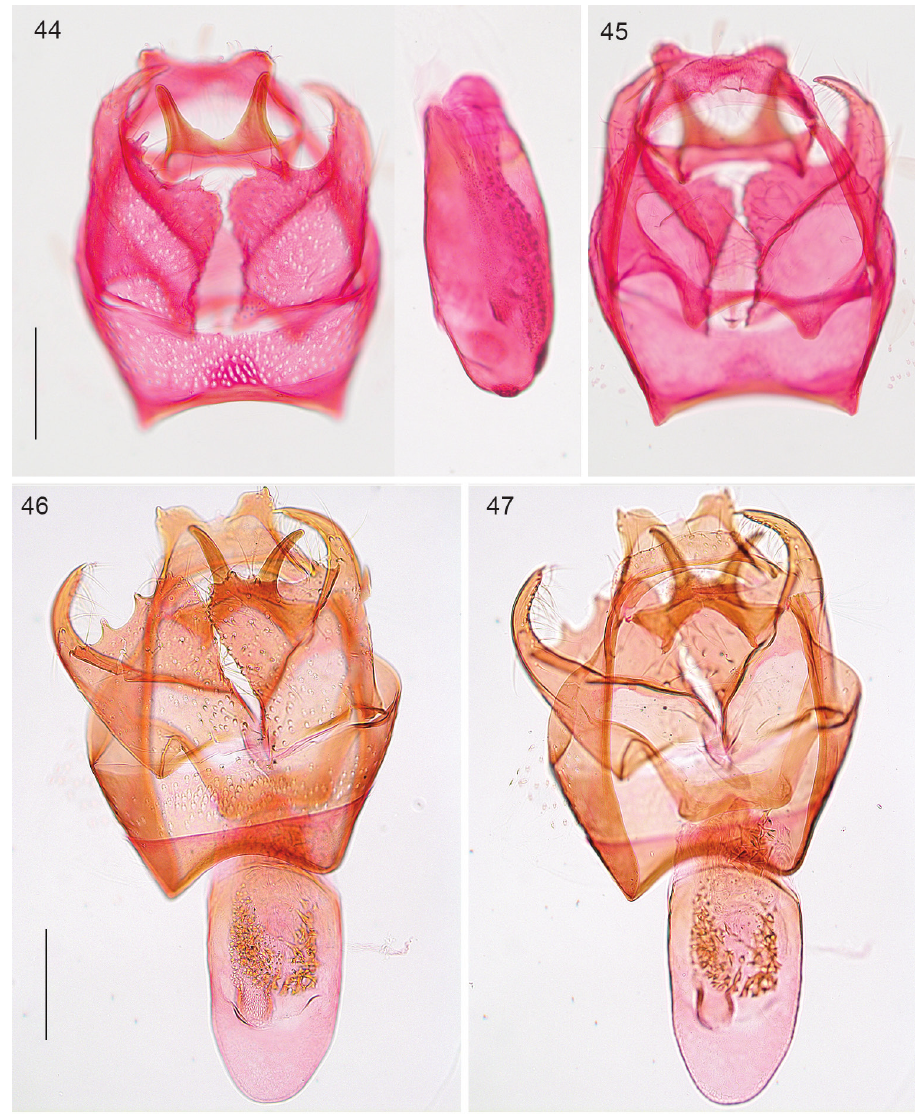
Figures 44–47. Stigmella species, male genitalia. 44, 45 S. costaricensis , holotype 46, 47 S. intronia , holotype. Scale bars: 100 µm.